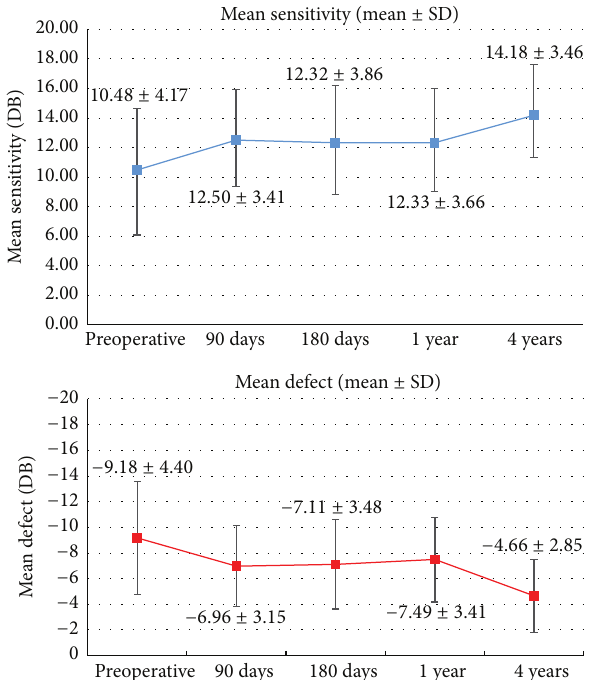
Figure 1: Mean sensitivity and mean defect values before and after surgery (mean ± standard